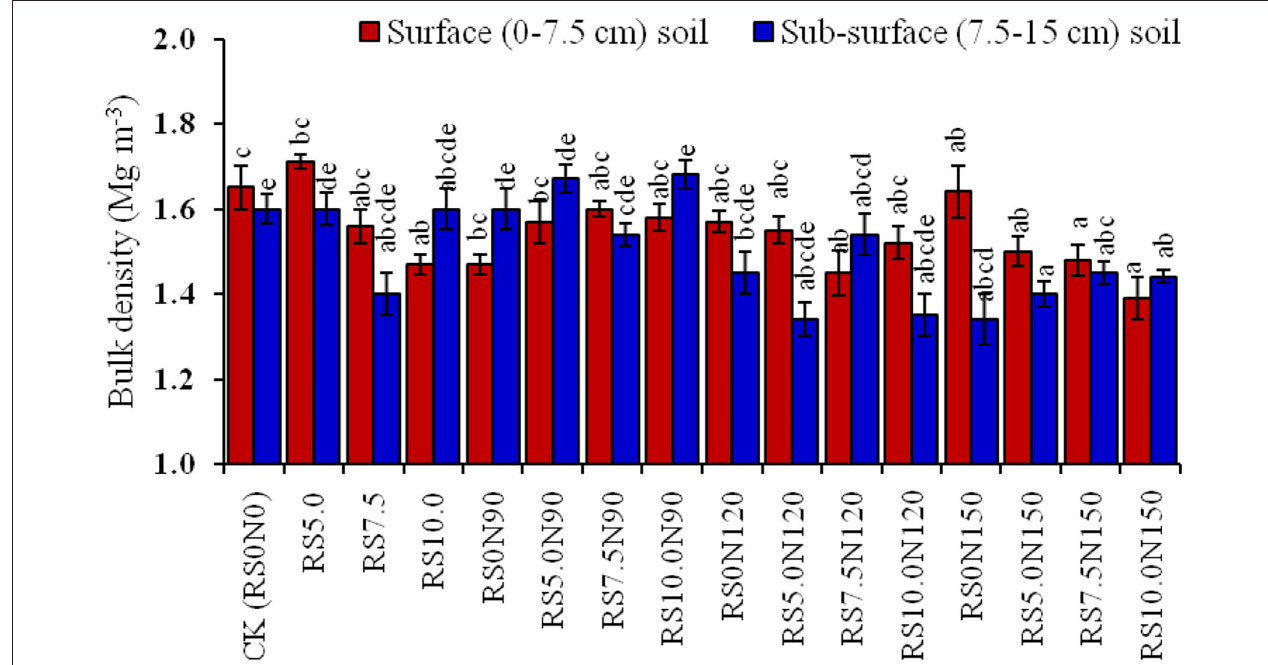
FIGURE 2 | Effect of fertilizer-N application and rice straw (RS) incorporation on bulk density (B D , Mg m − 3 ) in the surface (0–7.5cm) and sub-surface (7.5–15cm) soil depth under rice-wheat cropping system in north-western India. Line bars indicate standard error frommean . The values for a soil depth, followed by different letters are significantly different at p < 0.05 by Duncan’s multiple range test